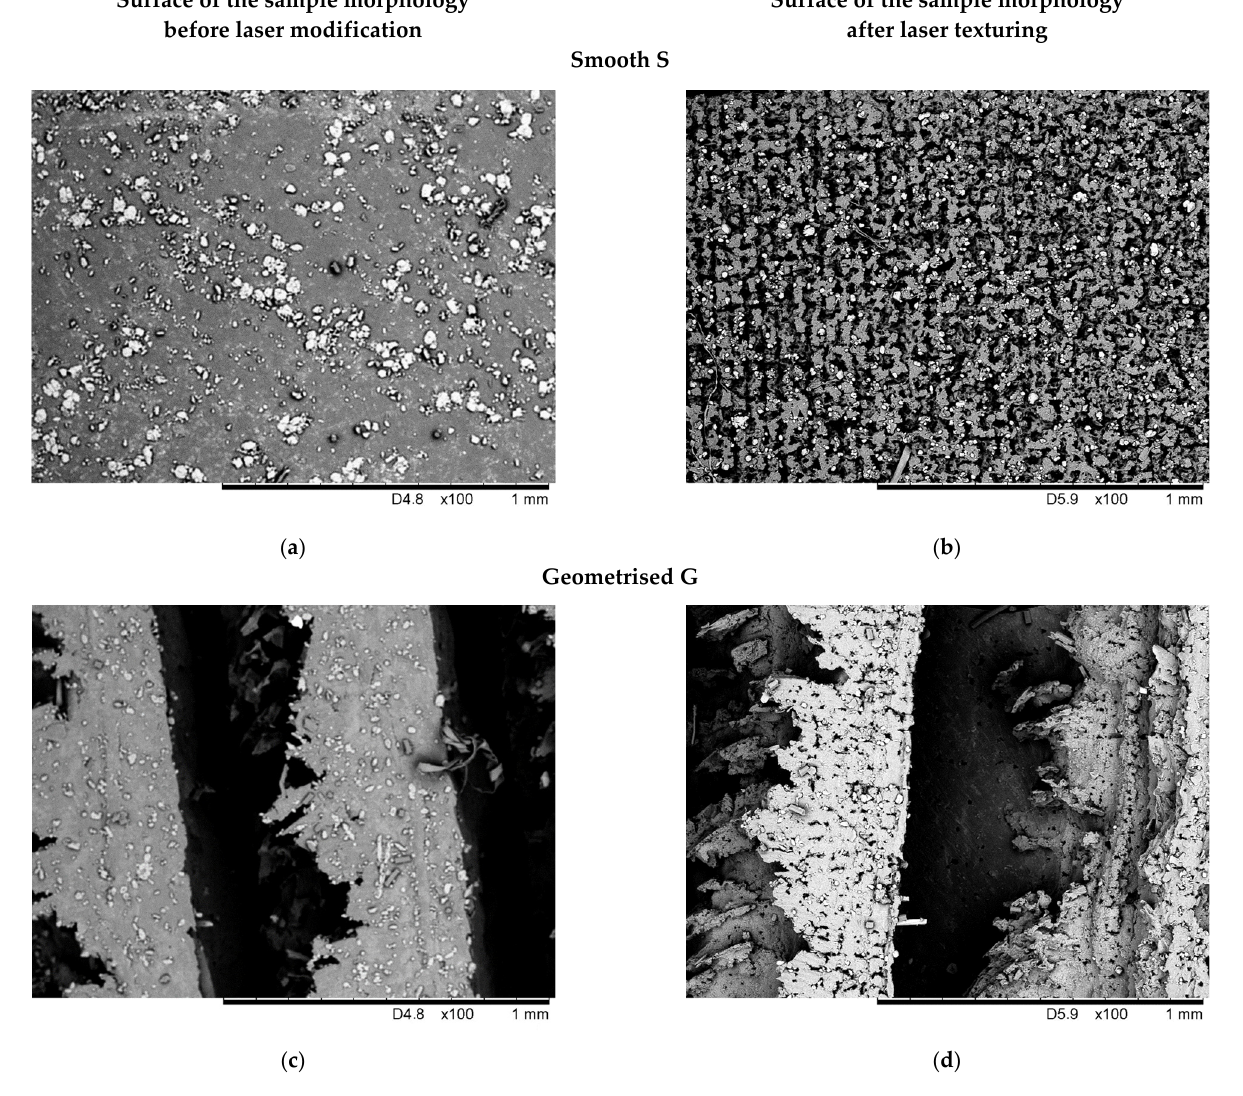
Figure 8. SEM image of the surface morphology of samples before and after laser texturing: ( a , c ) surface of the smooth and geometrised samples morphology before laser modification; ( b , d ) surface of the smooth and geometrised samples morphology after laser texturing.